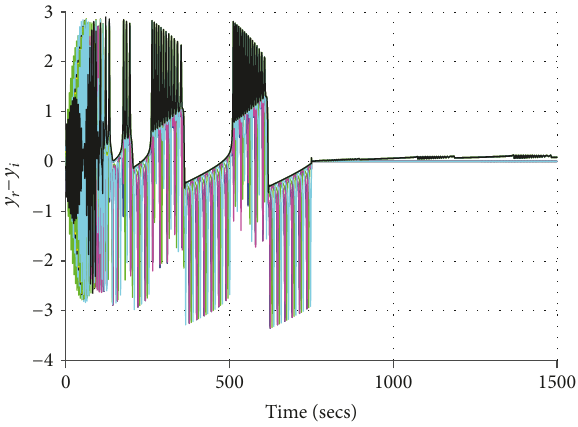
Figure 12: Errors between the outputs of β -cell Σ , before and after application of the coupling signal v the islet Σ i